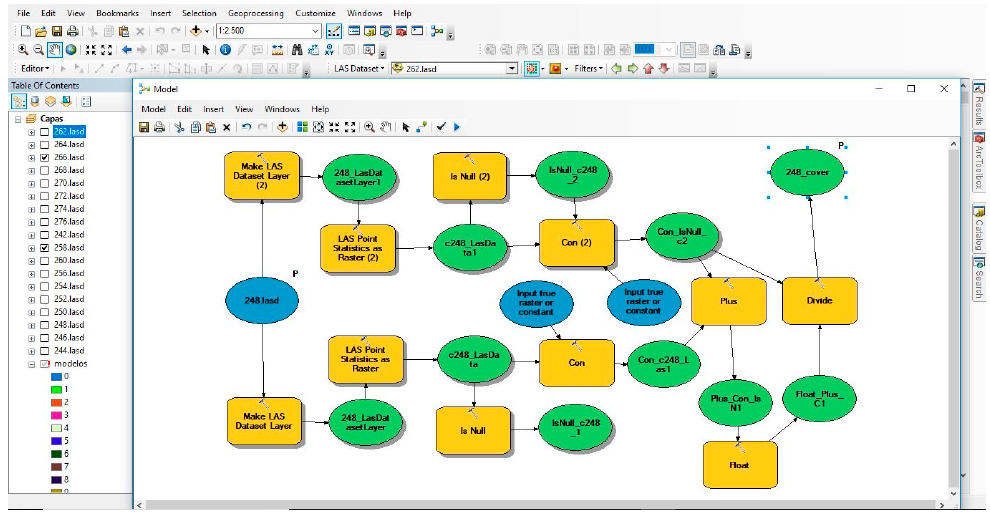
Figure 8. General calculation process of the FCC in Model Builder.